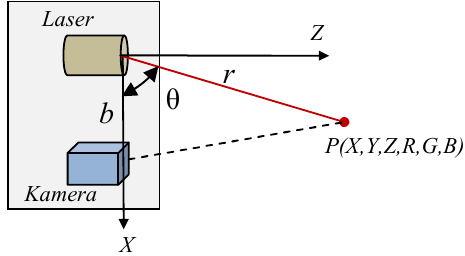
Figure 5. Principal of active triangulation